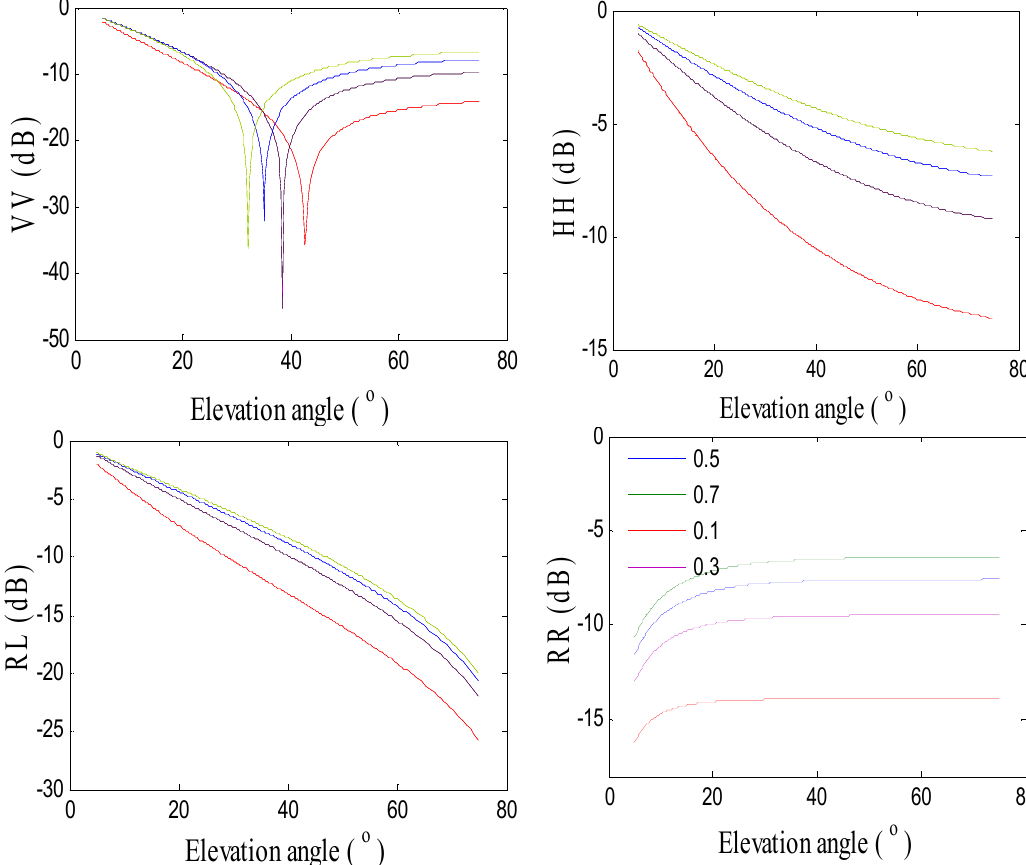
Figure 6. Coherent scattering coefficients of different snow densities (g/cm 2 ) at linear (VV and HH) and circular polarizations (RR and LR).